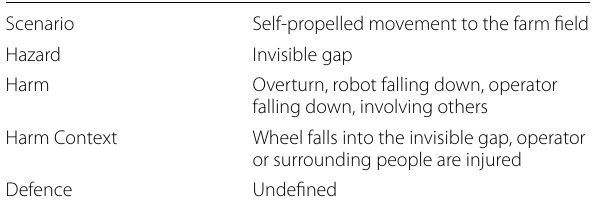
Table 1 Risk assessment table 1